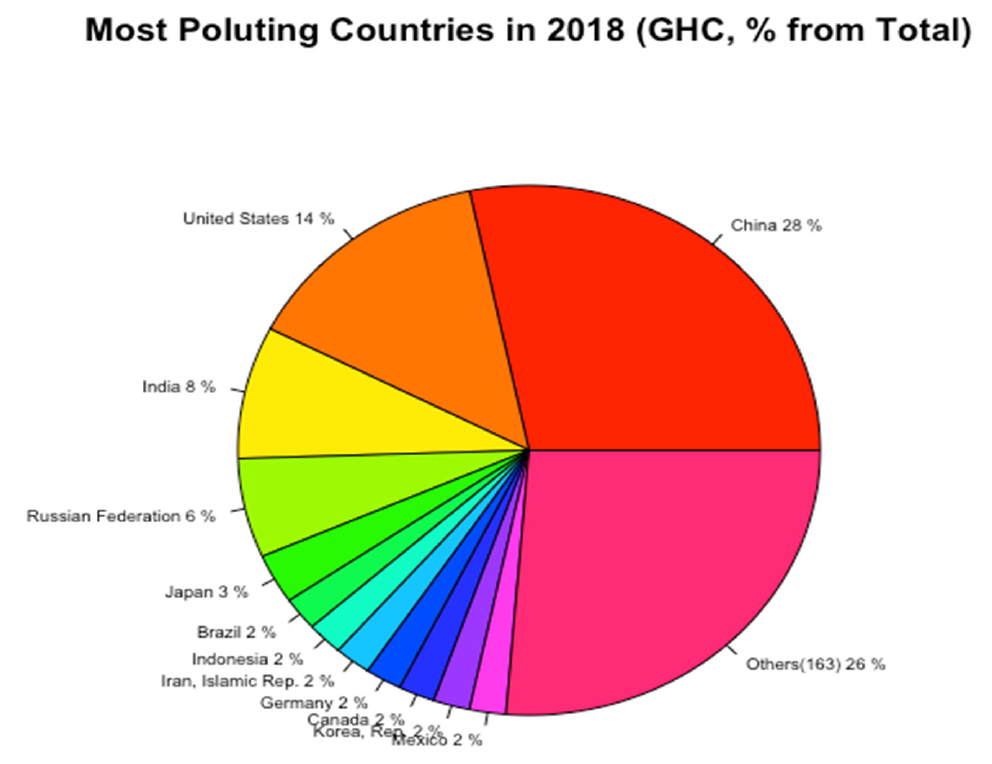
Figure 4. Contribution of world top polluters to total GHG emission (2018).